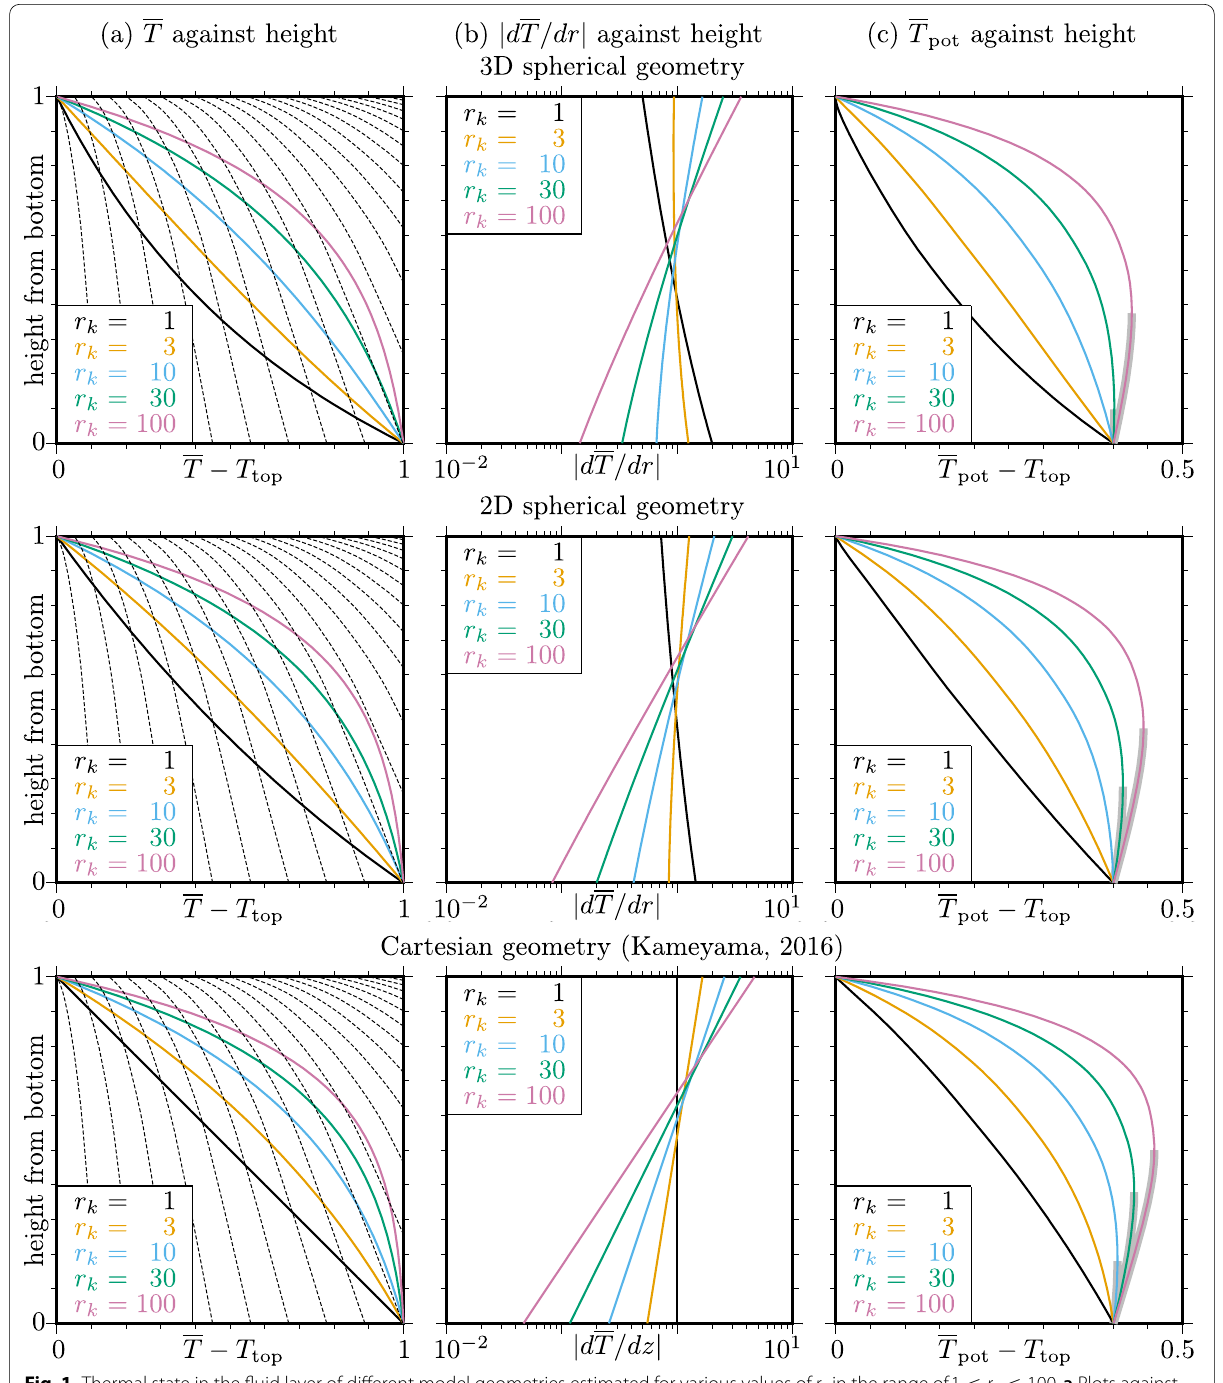
Fig. 1 Thermal state in the fluid layer of different model geometries estimated for various values of r k in the range of 1 ≤ r k ≤ 100 . a Plots against height from the bottom surface of the reference temperature T . Also shown by thin dashed lines for comparison are the plots of several adiabats against height. b Plots against height of the magnitude of the gradient of temperature | d T / d r | (or | d T / d z | ) in the radial (vertical) directions. c Plots against height of the potential temperature T pot . Also shown by thick gray lines are the ranges of depths where the thermal stratification given by T is stable owing to the increase in T pot with